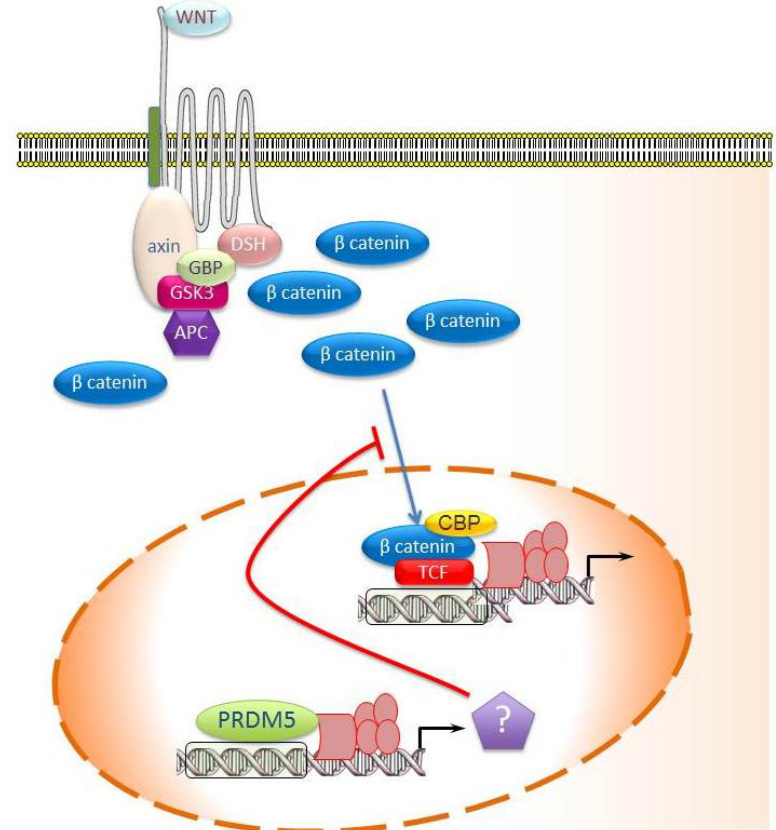
Figure 3. (cid:51)(cid:53)(cid:39)(cid:48)(cid:24)(cid:3)(cid:85)(cid:72)(cid:74)(cid:88)(cid:79)(cid:68)(cid:87)(cid:72)(cid:86)(cid:3)(cid:87)(cid:75)(cid:72)(cid:3)(cid:58)(cid:81)(cid:87)(cid:18)(cid:533) -catenin signaling in normal cells and in cancer cells.